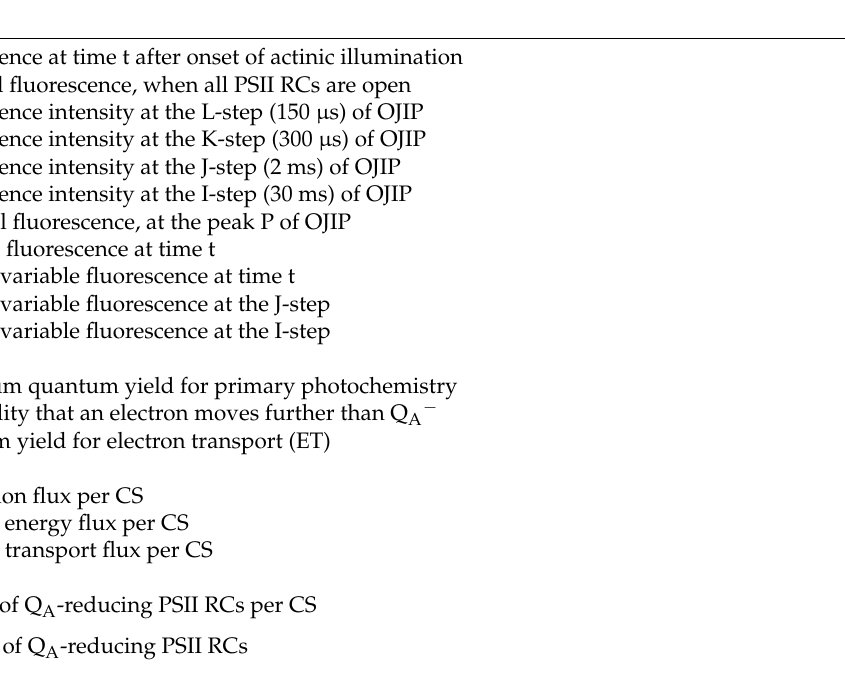
Table 1. Formulae and explanation of the technical data of the OJIP curves and the selected JIP-test parameters used in this study 1